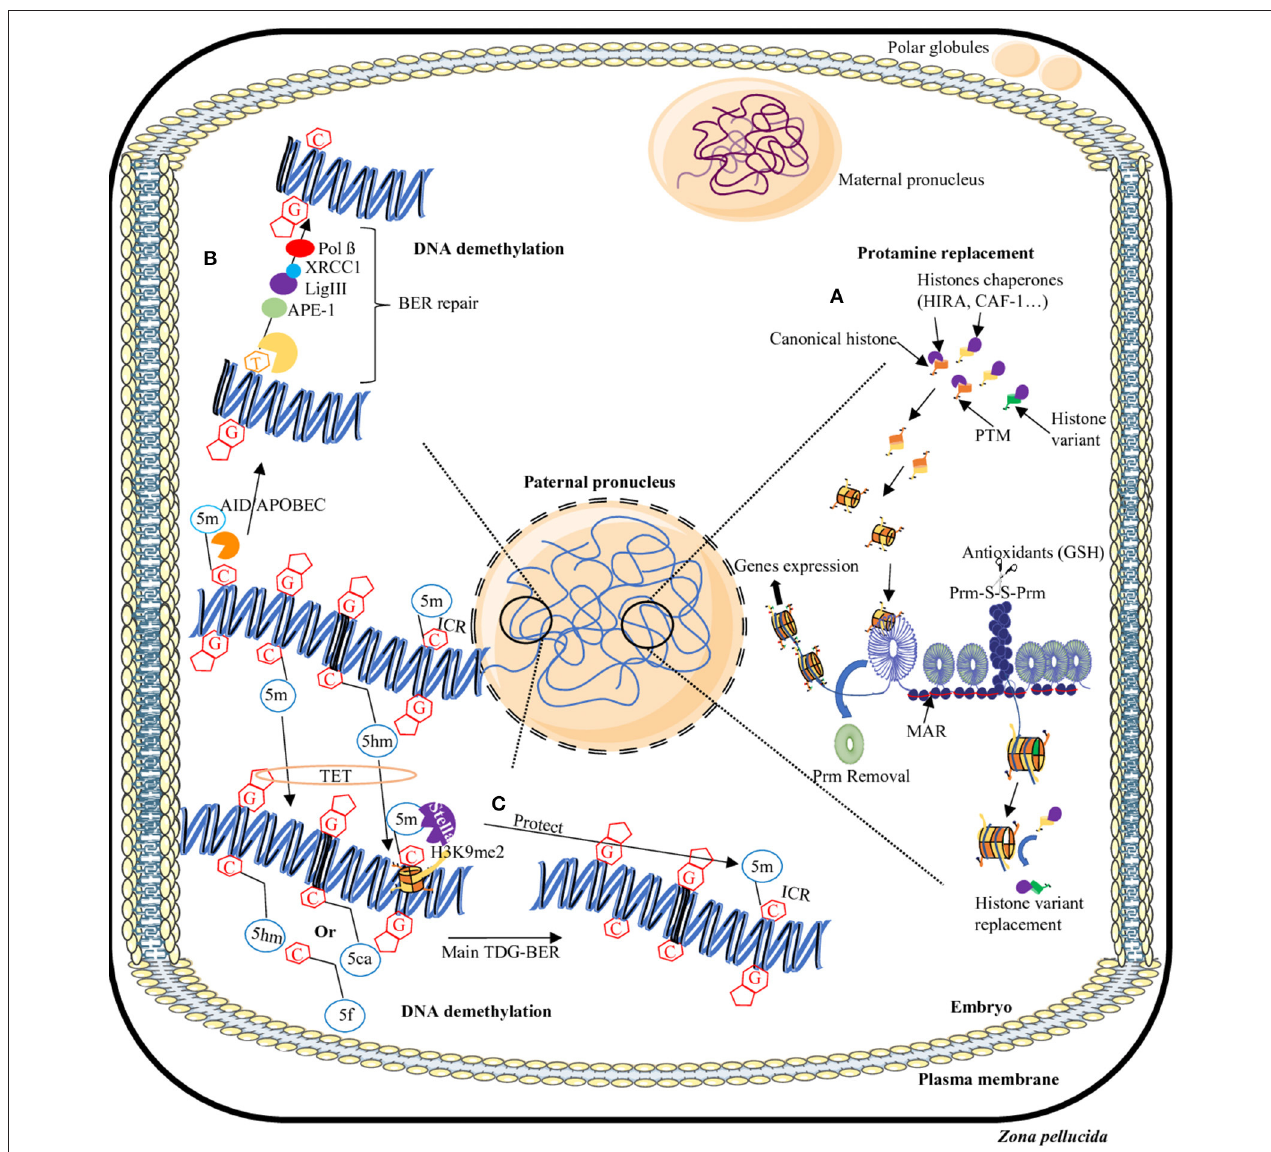
FIGURE 2 | Dynamics of epigenome reprogramming of the male pronucleus. After fertilization, in one cell embryo, the sperm nucleus undergoes many remodeling events. First, protamines are replaced by maternally-derived histones (A) . In addition, in some areas of the sperm nucleus where persisting histones remain, some will be replaced by canonical or other variants. Furthermore, the majority of 5-methylcytosine residues (5 mC) will be erased by two processes: a TET-TDG-BER repair process that will introduce non-methylated cytosines (C) or the AID/APOBEC/BER pathway that will change mC in thymine (T) then will repair the T-G mismatches in non-methylated cytosines (B) . Some regions will be protected from DNA demethylation including repeats elements, transposons, and imprinting control regions (ICR) thanks to the presence of the Stella protein and H3K9me2 histone modification (C) . AID/APOBEC, cytidine deaminase; APE, Apurinic/Apyrimidic endonuclease; BER, Base excision repair; C, cytosine; G, guanine; GSH, Glutathione; 5m, 5-methylcytosine; 5hm, 5-hydroxymethylcytosine; 5f, 5-formylcytosine; 5caC, 5-carboxycytosine; Lig, Ligase; MAR, matrix attachment region; Pol, Polymerase; Prm, Protamine; PTM, post-translational modifications; S-S, disulfide bridge,